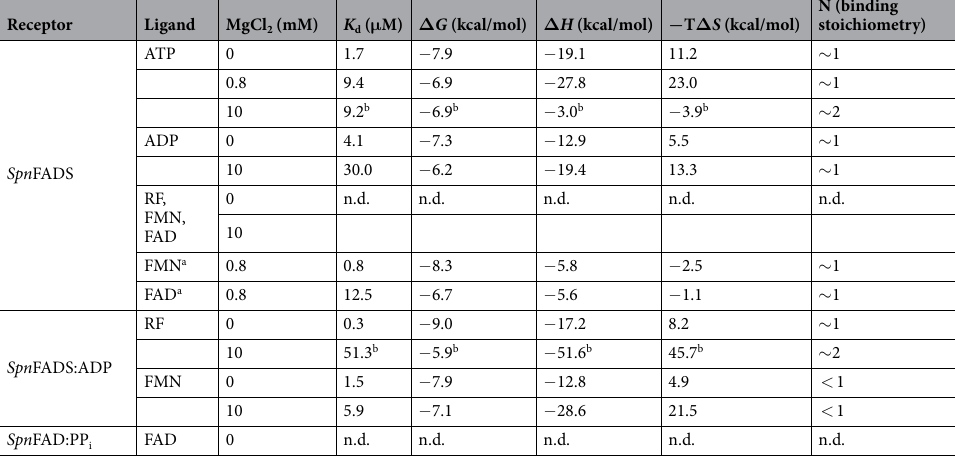
Table 2. Thermodynamic parameters for the interaction of Spn FADS with the substrates and products of its activities obtained by ITC. Data obtained at 20 °C in 20 mM PIPES, pH 7.0. Estimated errors in K d are ± 20% and ± 0.3 kcal/mol in Δ H and –T Δ S . n.d. No enthalpic change was detected along the titration. a Measurements